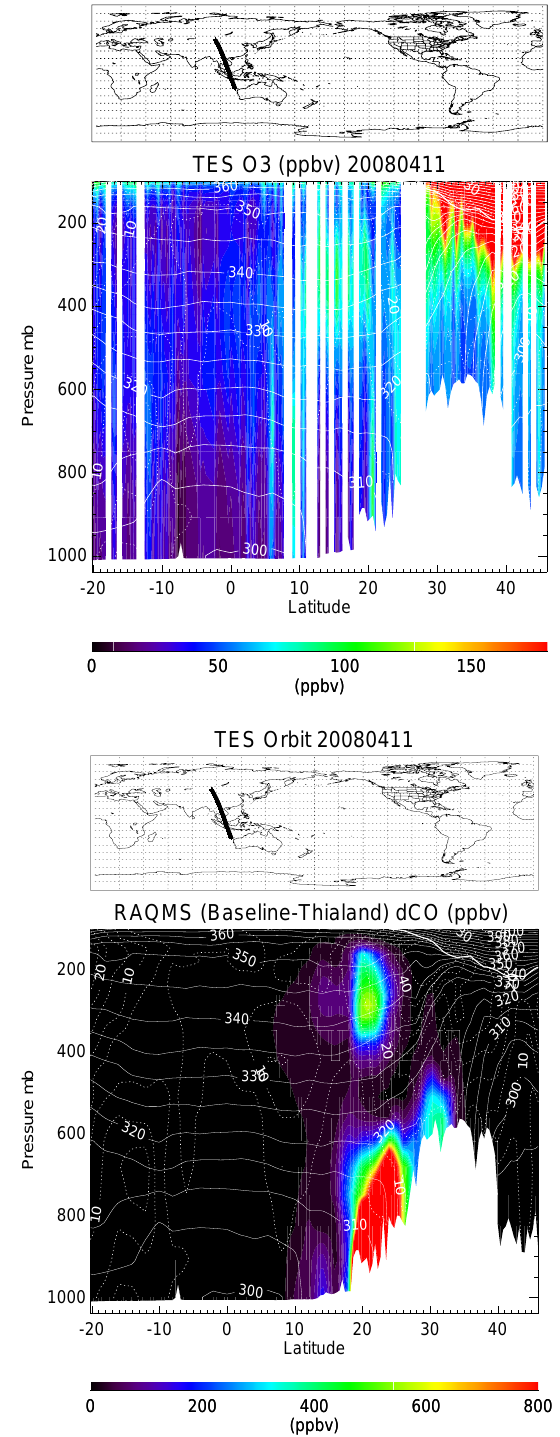
Fig. 10. (Top panel) Observed TES ozone over Thailand and south of the Himalayas. (Bottom panel) Observed TES CO.